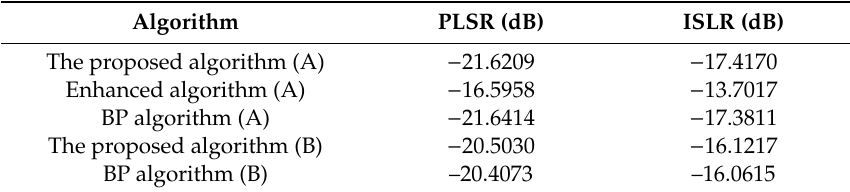
Table 2. Imaging performance of di ff erent